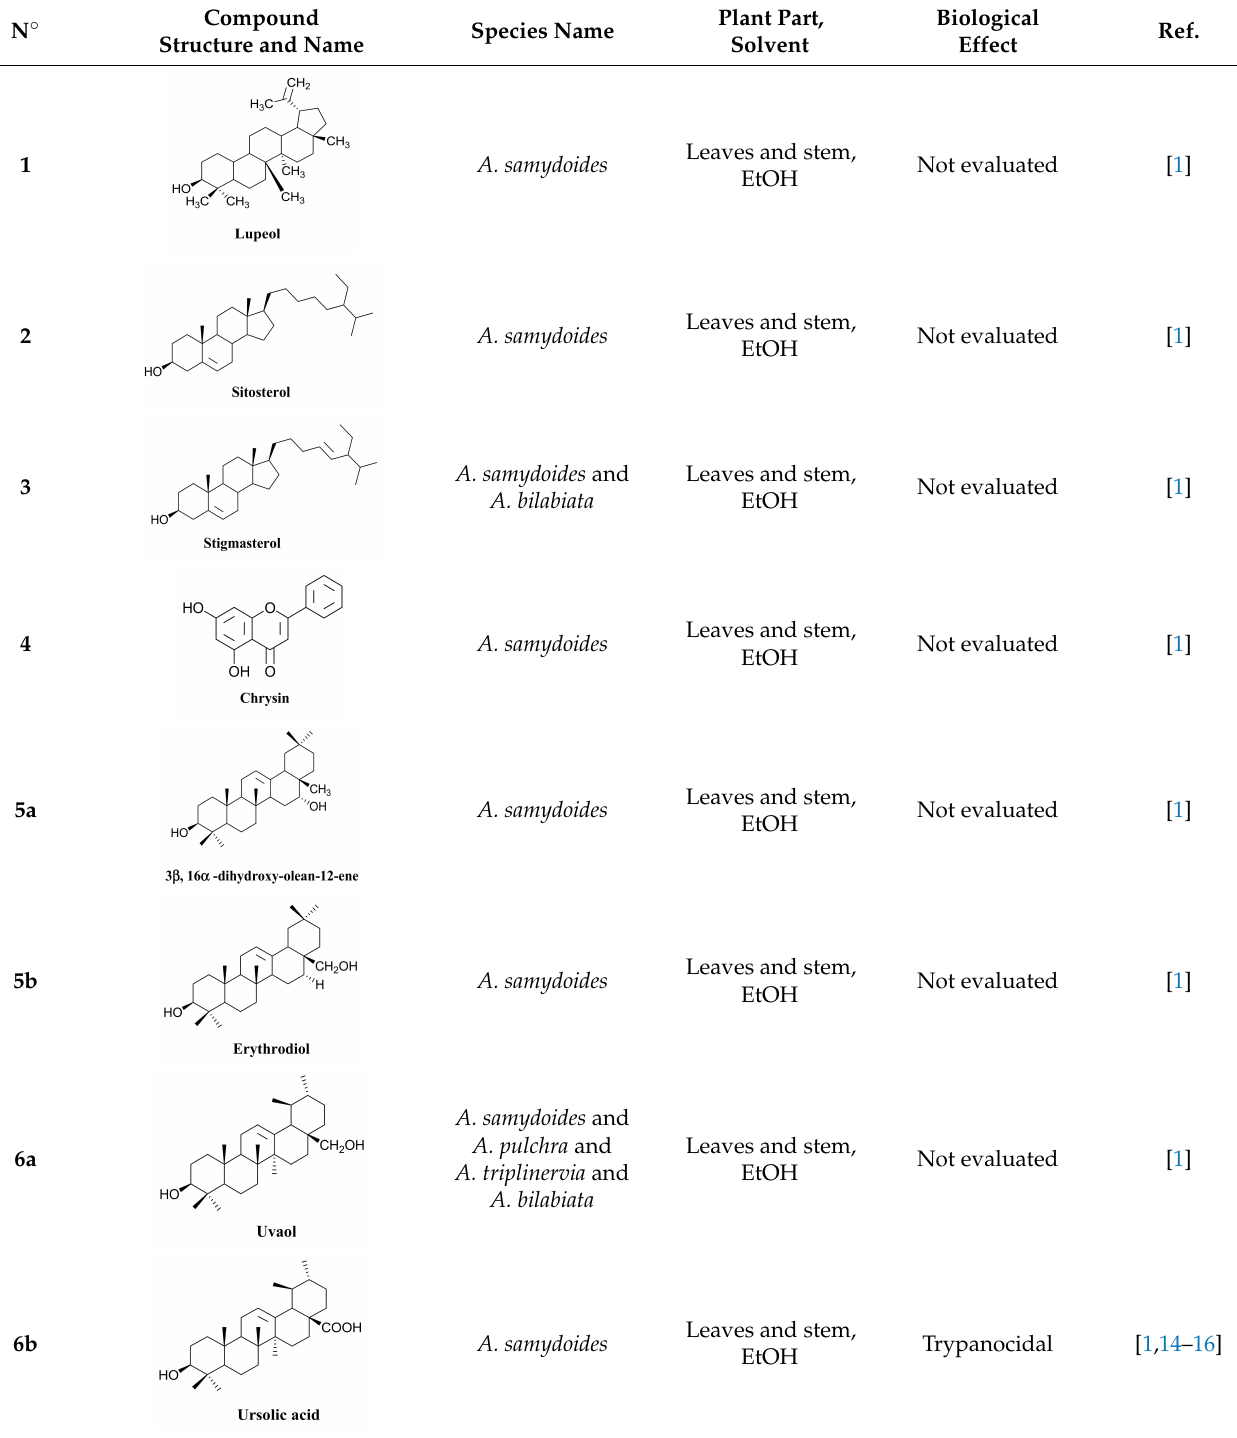
Table 1. Structure and bio-pharmacological properties of isolated compounds from A. samydoides